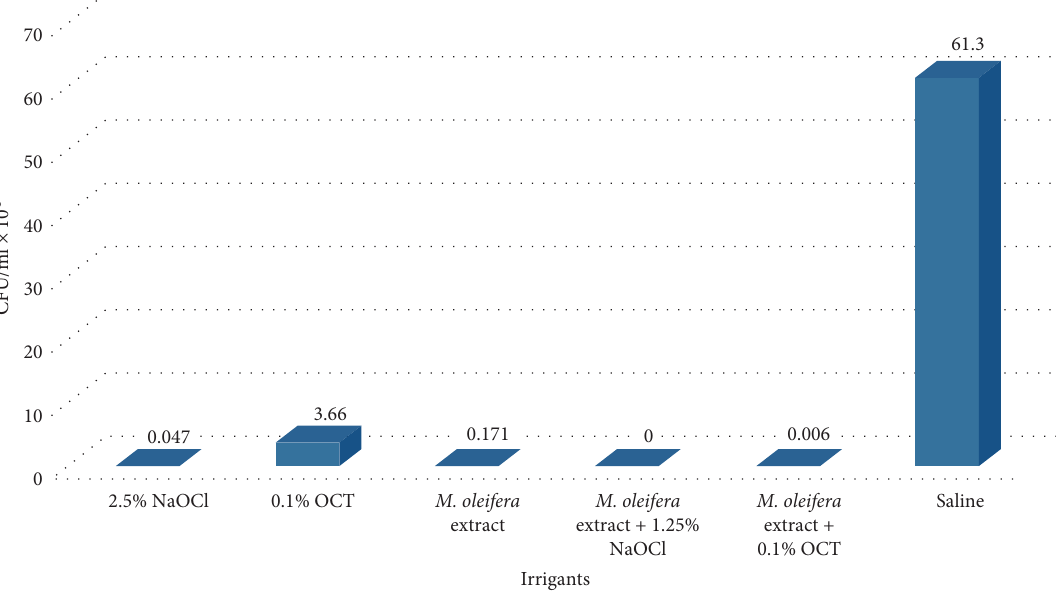
T ABLE 3: Comparison between the median and range values of CFU/ml in the tested groups after application of the irrigants. Irrigants Median (range) ∗ Group 1 (2.5 % NaOCl)